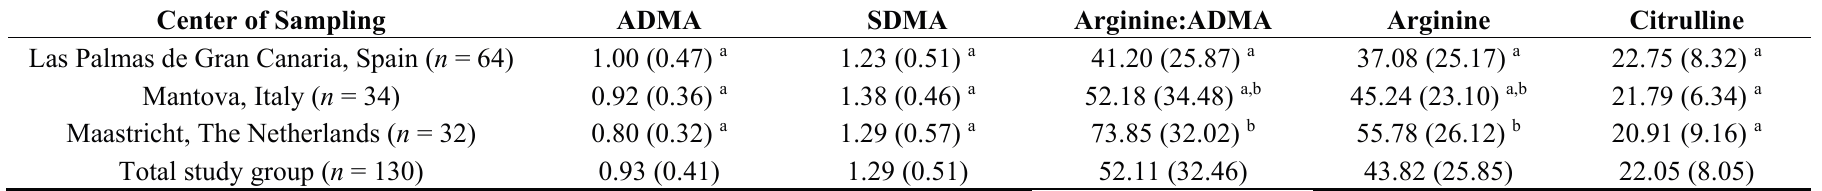
Table 2. Dimethylarginines, arginine, and citrulline levels and ratios in very low birth weight infants per center of sampling.